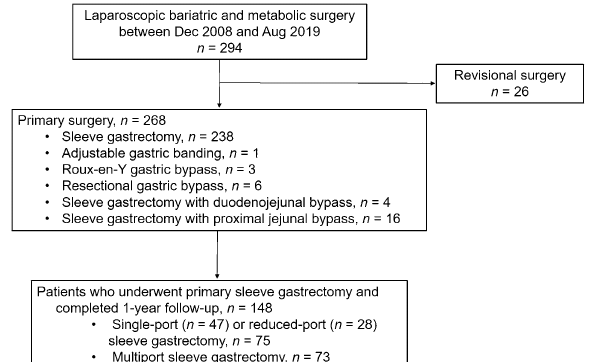
Figure 1. Patient selection flow